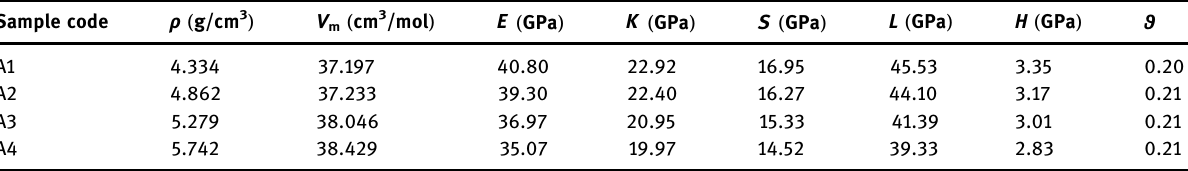
Table 2: Mechanical properties of the A1 – A4 coded glass system Sample